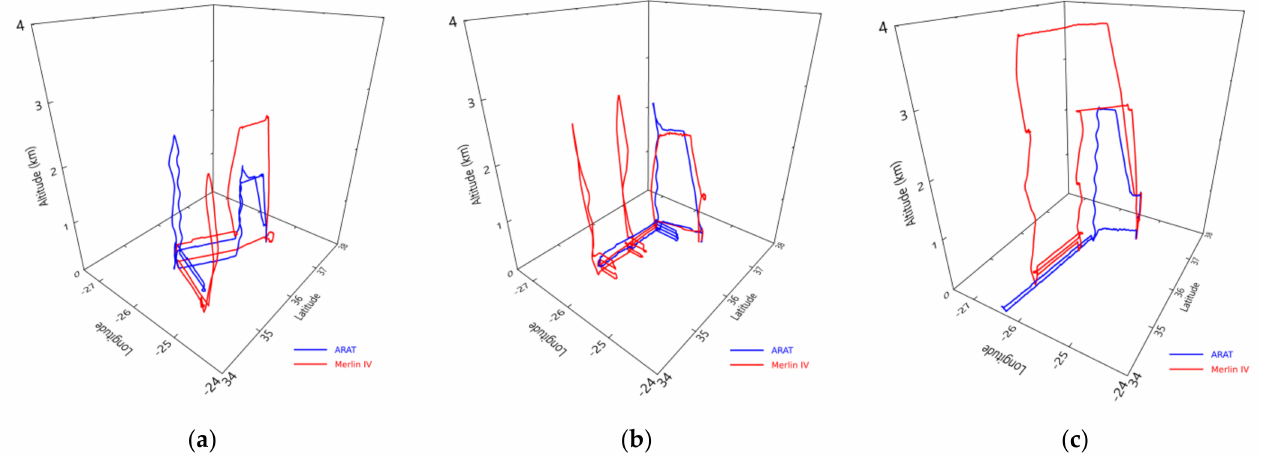
Figure 1. Flight plans: ( a ) perpendicular axes (approximately 100 km), ( b ) a long axis (200–300 km) with three perpendicular segments, and ( c ) one long axis of 300 km. Tracks of ARAT and Merlin IV are depicted in blue and red,